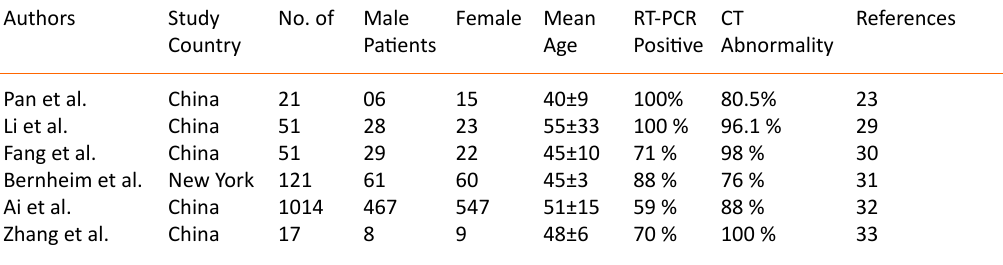
Table 1. Comparison of RT-PCR and CT scan reports in patients infected with COVID-19 Authors Study No. of Male Female Mean RT-PCR CT Country Patients Age Positive